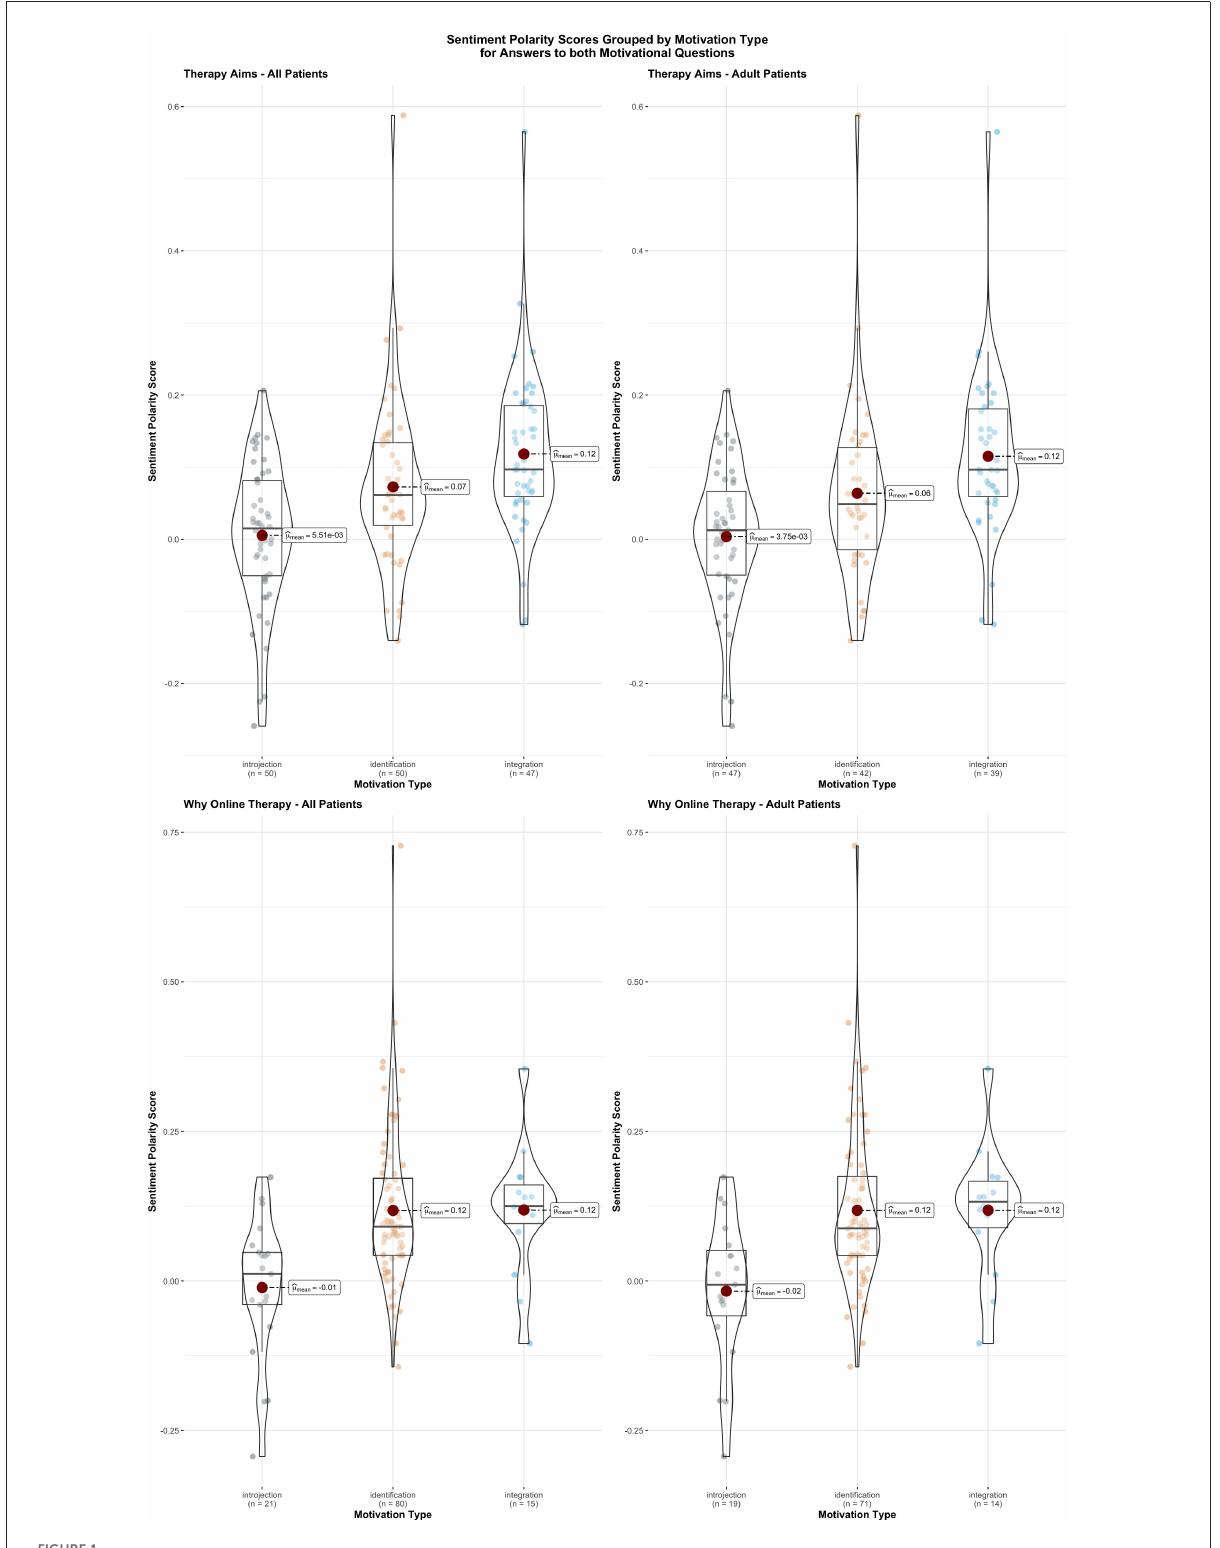
FIGURE1 The correlation scores between sentiment polarity and motivation type, grouped by motivational question and age group. Groups means as well as box and whisker plots are added for each violin